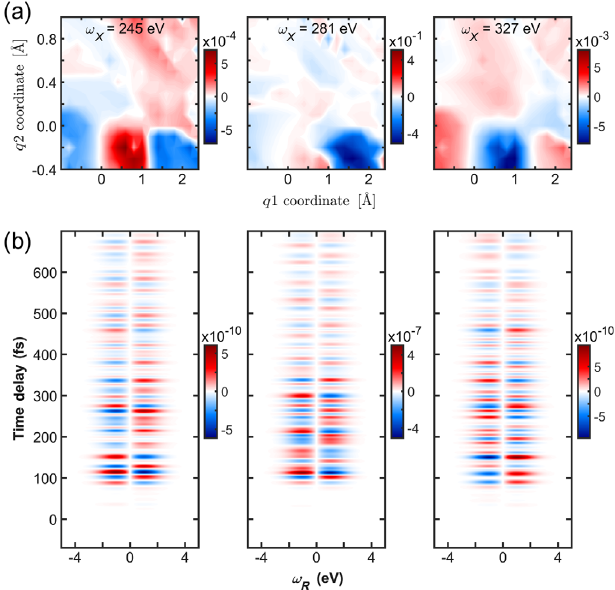
FIG. 13. Molecular polarizabilities of uracil and STRUECARS signal at three different probe wavelengths for z -polarized x-ray pulses. (a) Polarizability from Eq. (D7) in atomic units, in the two-dimensional nuclear space of the uracil Hamiltonian [59,60]. q 1 and q 2 are the nuclear degrees of freedom, with q 1 leading from the Franck-Condon point to the COIN, and q 2 leading to a local S 2 minimum. The indicated probe frequency enters Eq. (D7) as ω , with the middle panel at 281 eV, 10 eV below the bound X state carbon resonance, and the left and right panels significantly below and above this resonance, respectively. (b) STRUECARS signal associated with these polarizabilities. The same qualitative features are exhibited, with the signal in the middle panel being 3 orders of magnitude stronger than the other two.